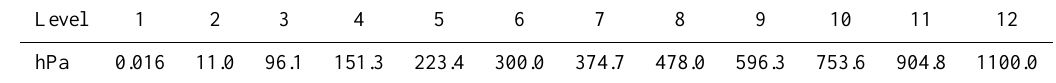
Table 1. IASI trapezoid layers in retrieval (hPa).